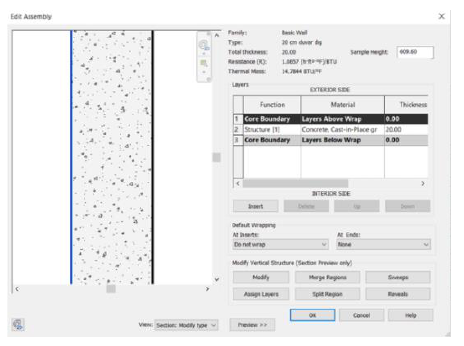
Figure 13 Reinforced concrete exterior wall defined for the existing building in the Revit program